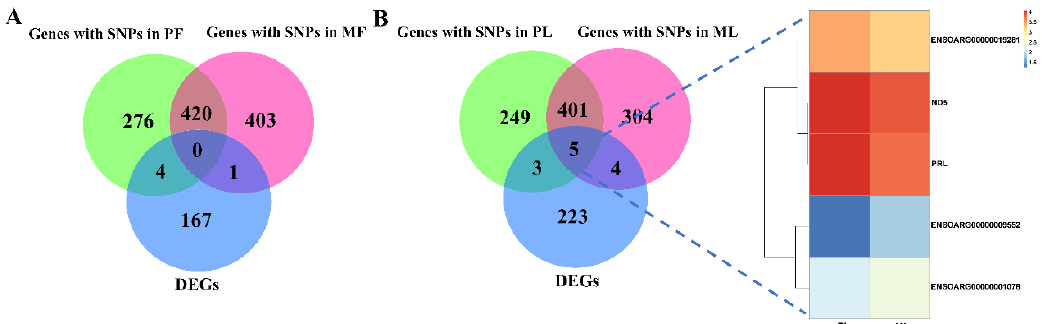
Figure 5. The identified genes with single nucleotide polymorphisms (SNPs) in PF, PL, MF and ML. ( A ) The identified genes with SNPs and their intersections with DEGs in PF and MF; ( B ) the identified genes with SNPs and their intersections with DEGs in PL and ML; five key DEGs with SNPs are also shown by heat map.